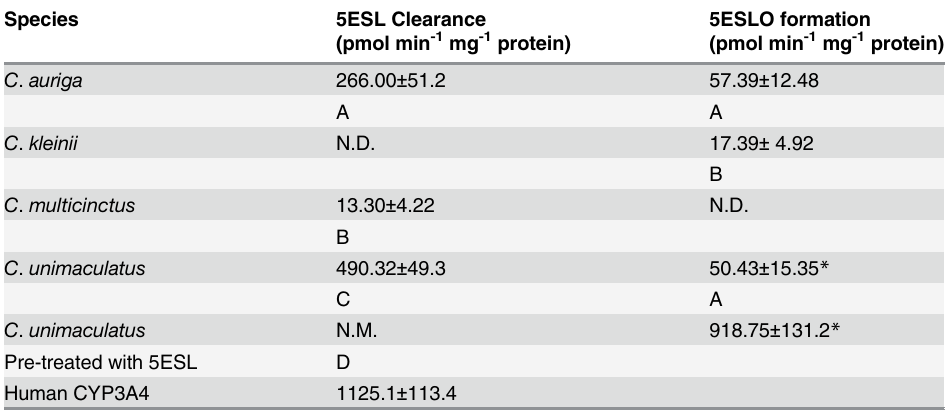
Activities were determined using 11 μ M 5ESL. Values are represented as the mean ± SD (n = 6 – 8). N.D. = Not detected; N.M. = Not